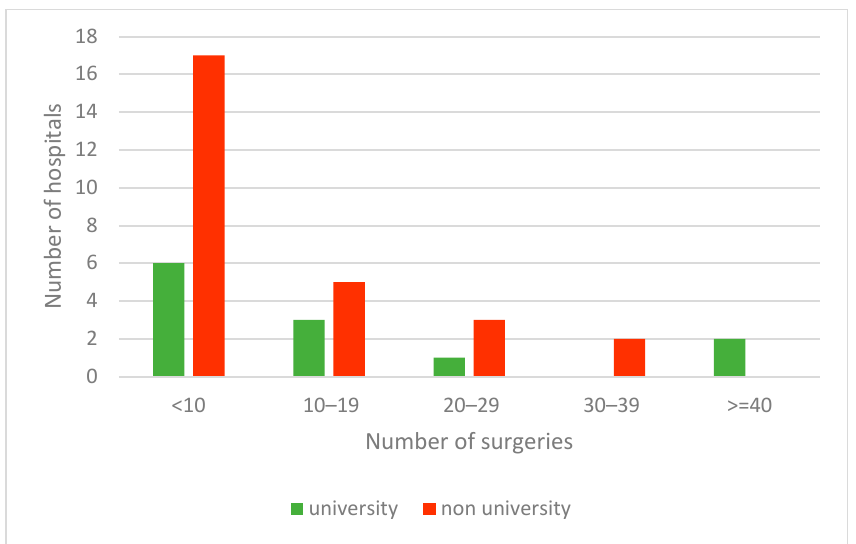
Figure 2. Number of procedures of laparoscopic inguinal hernia repair of university and non-university hospitals in 2019. Table 4. Numbers of procedures of laparoscopic inguinal hernia repair (IHR) per pediatric surgical unit documented in the quality reports.